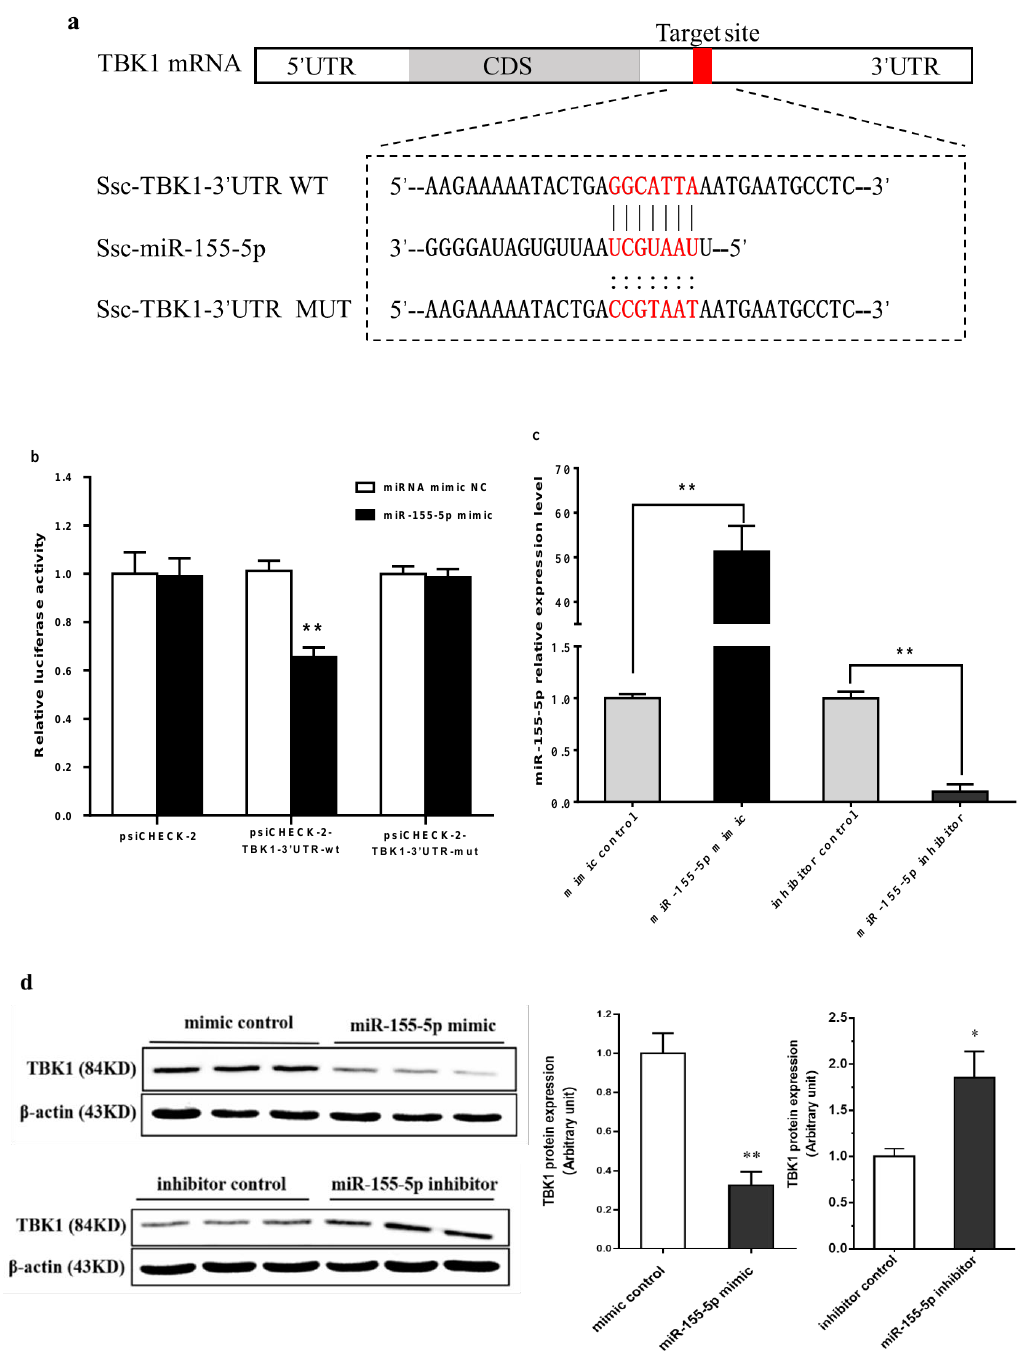
Figure 5. The miR-155-5p targets the 3’-UTR of TBK1. Sequence alignment of wild-type (WT) and mutated (MUT) putative miR-155-5p-binding sites in the 3’-UTR of TBK1 ( a ). Binding site and seed region of miR-155-5p are indicated in red. The repressive effect of miR-155-5p on the activity of TBK1 3’UTR was measured by dual-luciferase reporter activity ( b ). Sequence of WT binding site is GGCATTA, and the binding site of MUT is CCGTAAT. The influence of miR-155-5p mimic and inhibitor on miR-155-5p expression ( c ). The influence of miR-155-5p mimic and inhibitor on TBK1 protein expression ( d ). All data were expressed as means ± SD (bars represent the SD from three independent experiments). * p < 0.05, ** p < 0.01.